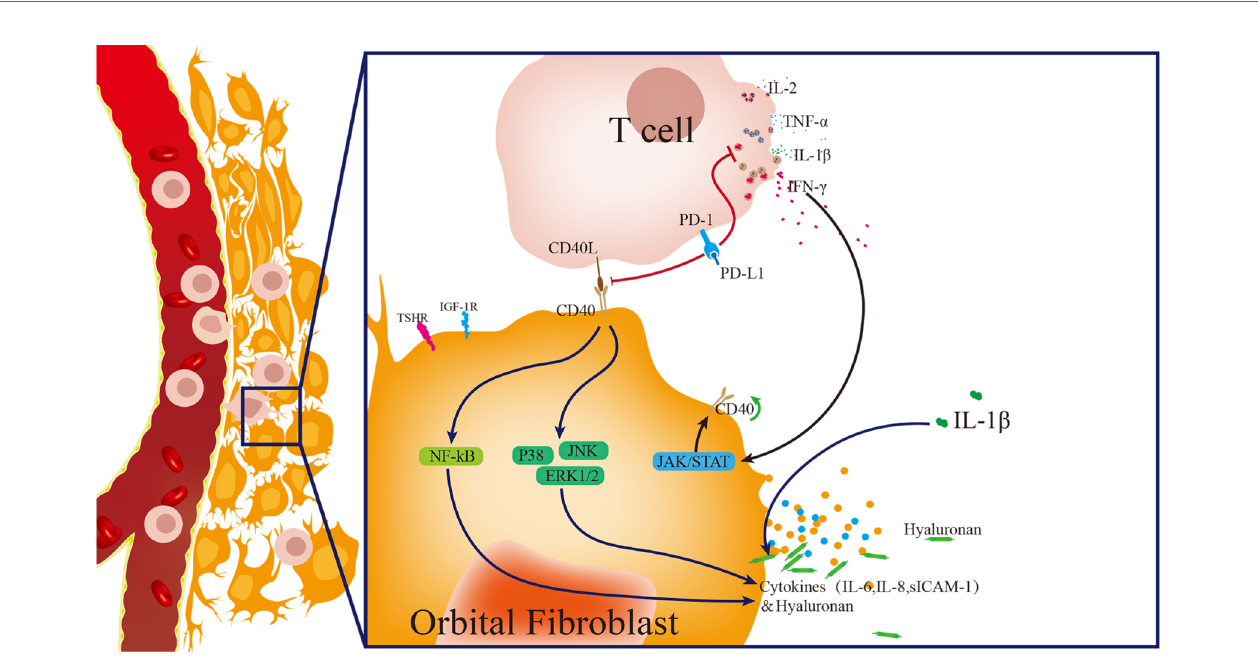
FIGURE 7 | Model of pathogenesis of TAO induced by T cells activating OFs, and PD-L1 blocking the progression of TAO. Activated T cells express abundant CD40L and release a large amount of cytokines, such as IL-1 b , IL-2, IFN- g and TNF- a . IFN- g up-regulates the expression of CD40 in OFs. IL-1 b induces the high expression of cytokines in OFs. T cells activate OFs via CD40-CD40L costimulatory molecules, thus up-regulating the phosphorylation of the downstream pathway proteins, including p38, ERK 1/2, JNK and NF- k B p65, and inducing the high production of sICAM-1, IL-6, IL-8, and hyaluronan. PD-L1 inhibits T cell activity, and thus weakens T cell-induced OFs activation, thereby signi fi cantly reducing the production of cytokines and hyaluronan in